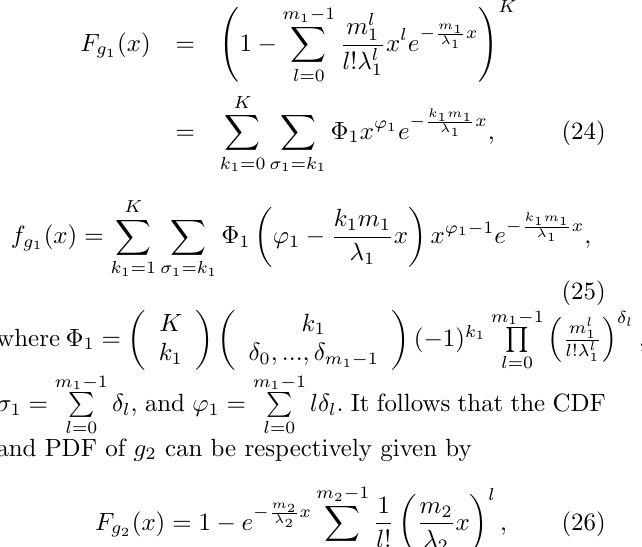
Algorithm 1 Proposed quadra-phase schemes for RF EH NOMA MEC